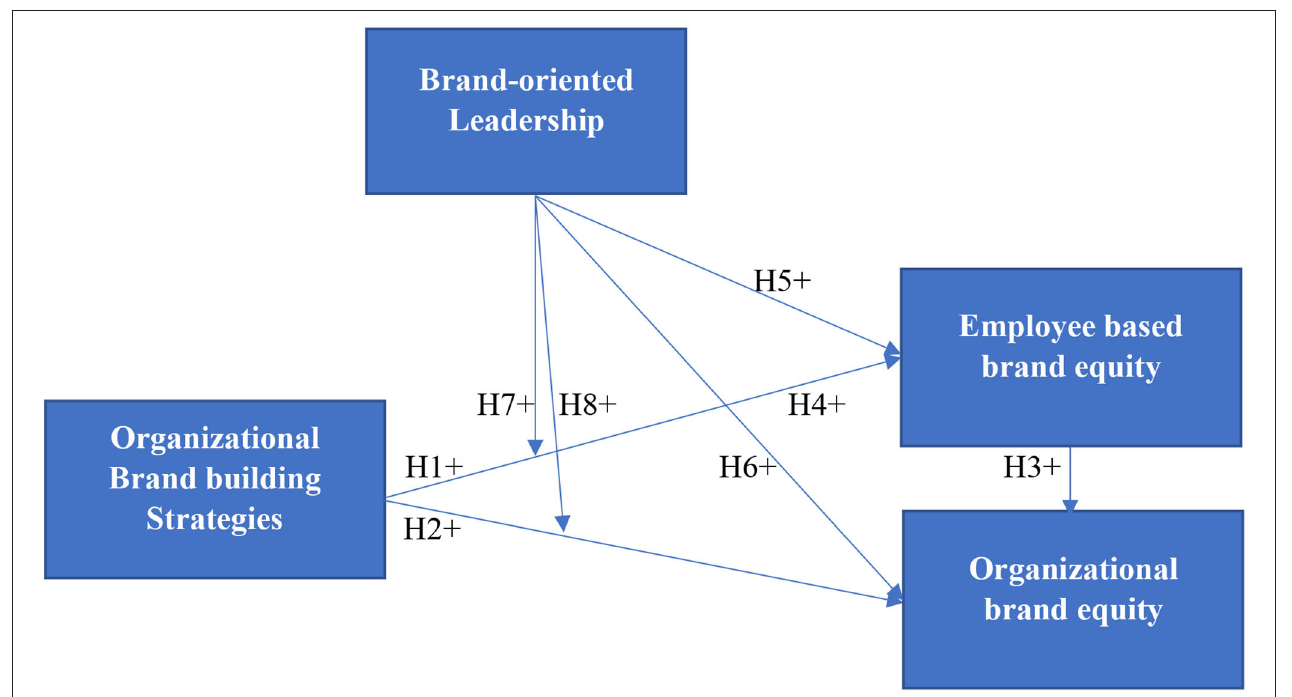
FIGURE 1 | Conceptual